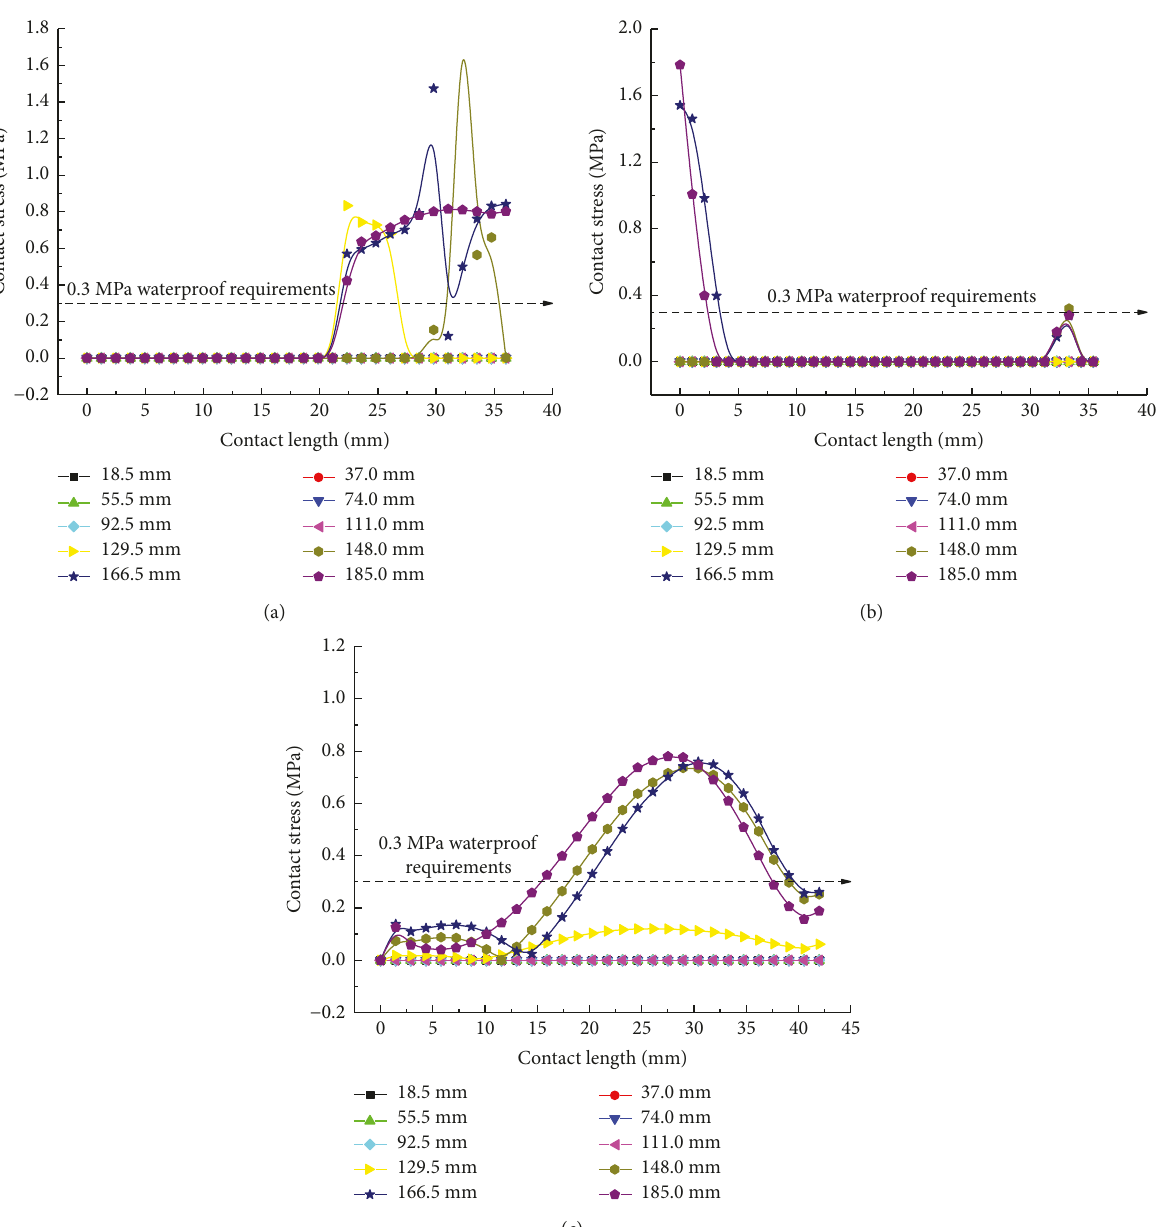
Figure 8: Contact stress curve of the second rubber ring before optimizing during translation: (a) contact pressure of line 1 for the second rubber ring, (b) contact pressure of line 2 for the second rubber ring, and (c) contact pressure of line 3 for the second rubber